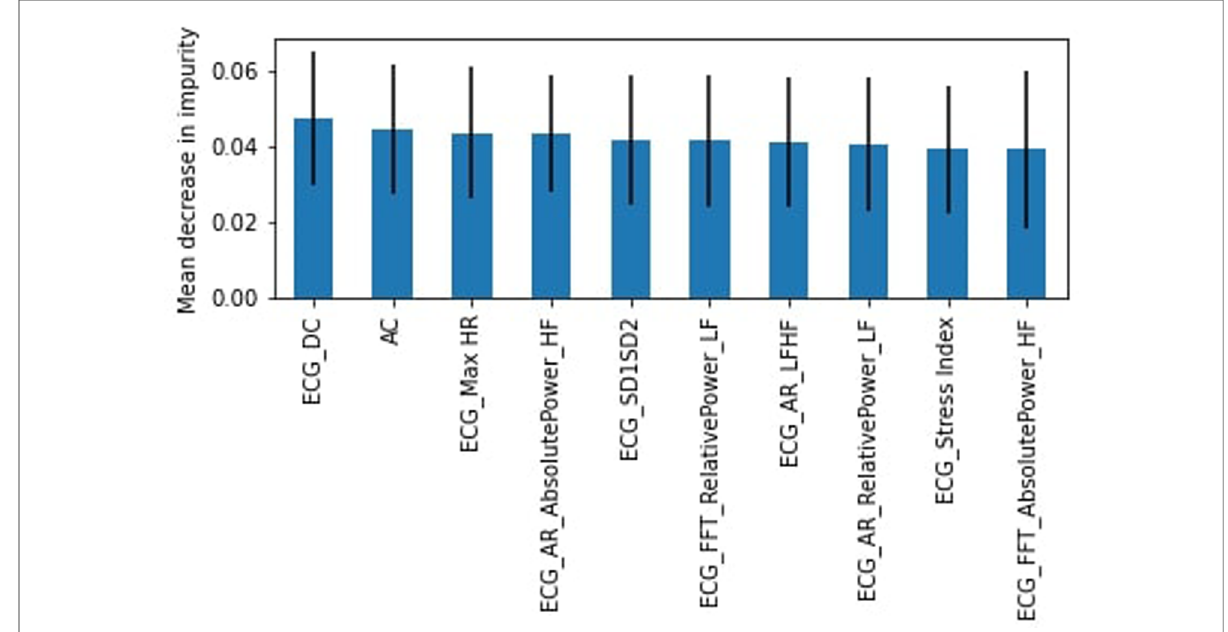
FIGURE 4 RF feature importance, healthy subjects.